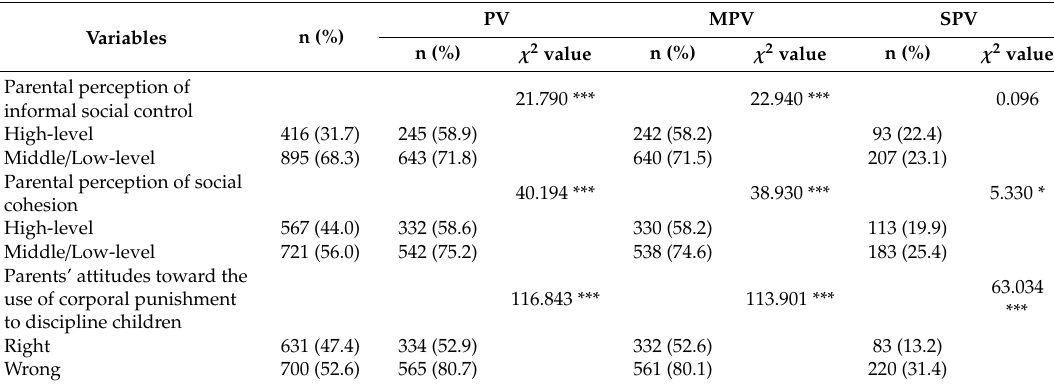
Table 3. Descriptive statistics for variable of parental perception of neighborhood collective e ffi cacy.